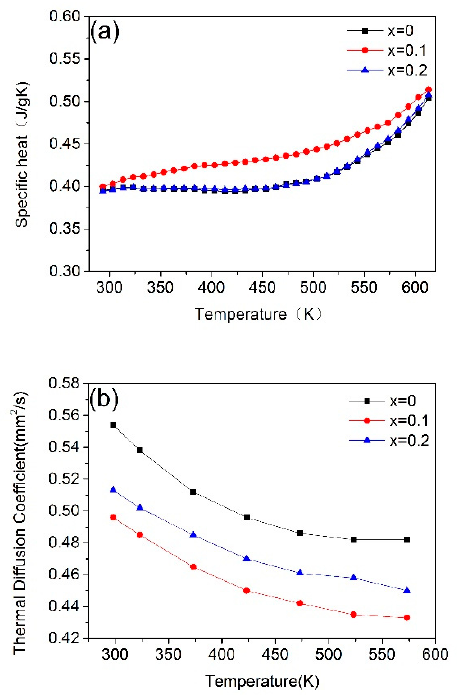
ff usion coe ffi cient ( b ) of Sm:LGN